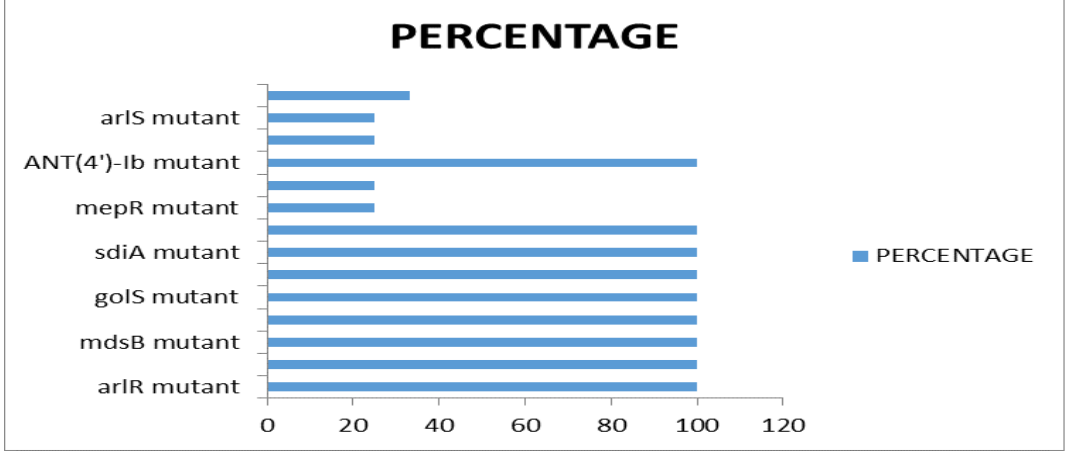
Figure 2. Percentage distributions of mutants’ genes categorized under ‘Perfect’.